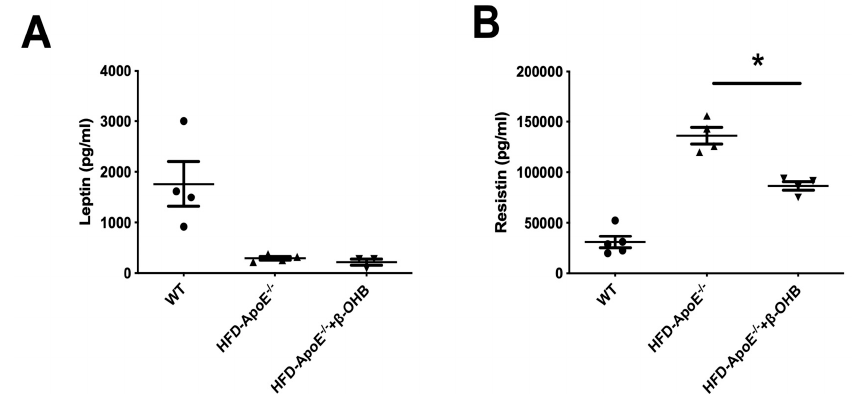
Figure 5. β -OHB decreases the production of resistin. The levels of leptin ( A ) and resistin ( B ) in plasma were analyzed by immunoassay analysis. WT, normal chow diet-fed C57BL/6J; HFD-ApoE -/- , high fat diet-fed ApoE knock-out; β -OHB, β -hydroxybutyrate. * p < 0.05.